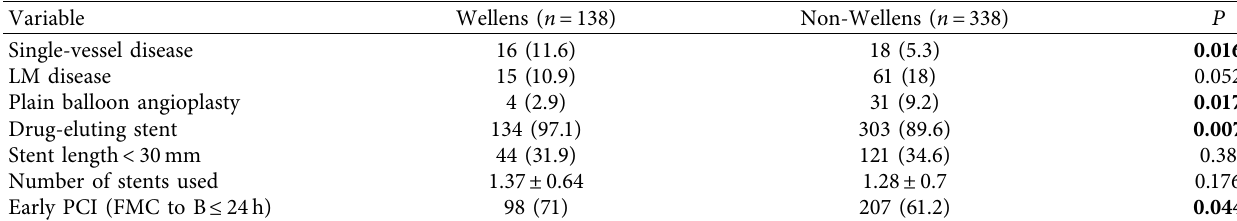
Table 2: Angiographic characteristics and treatment data of patients.